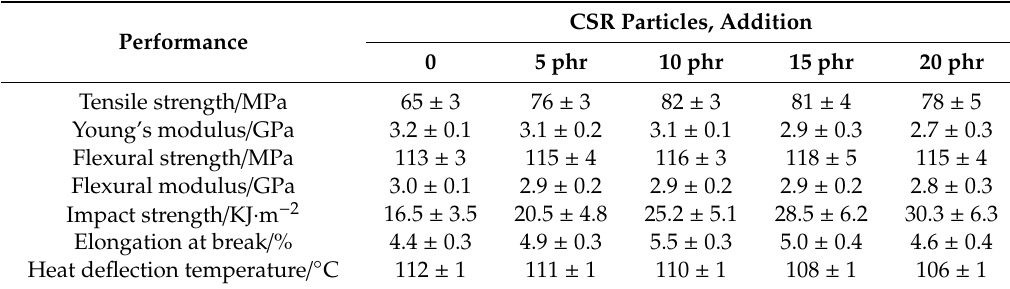
Table 3. Test results of CSR nanoparticles modified epoxy